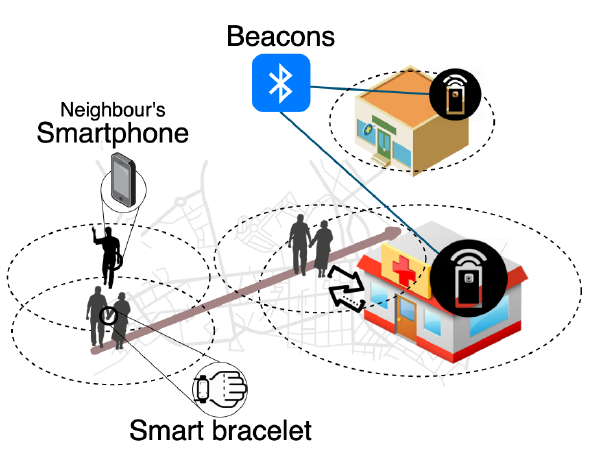
Figure 4. A technological solution proposed to detect loneliness